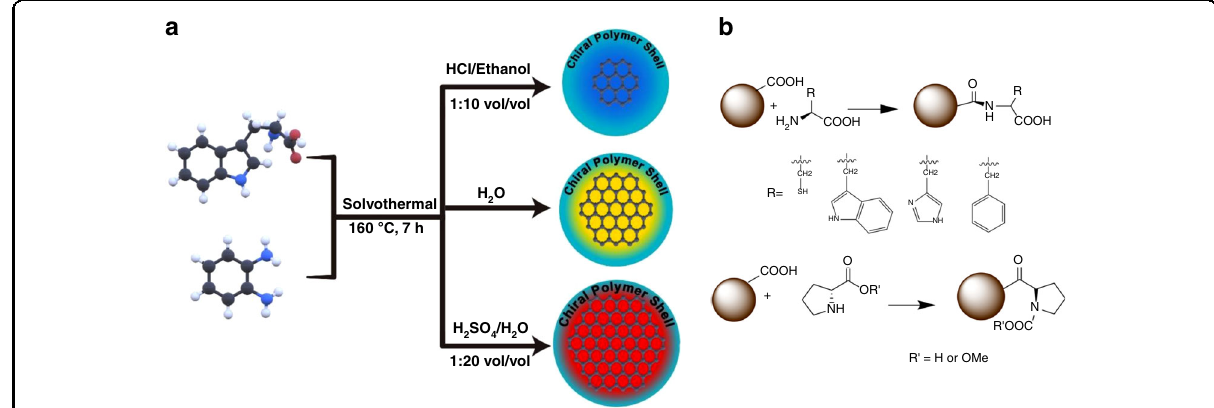
Fig. 3 Examples of bottom-up synthesis of chiral carbon dots. a Solvothermal synthesis from L-/D-tryptophan and phenylenediamine; b conjugation of amino acids at the surface of pre-synthesized CDs. a Adapted with permission from 59 Copyright 2021 Wiley-VCH GmbH. b